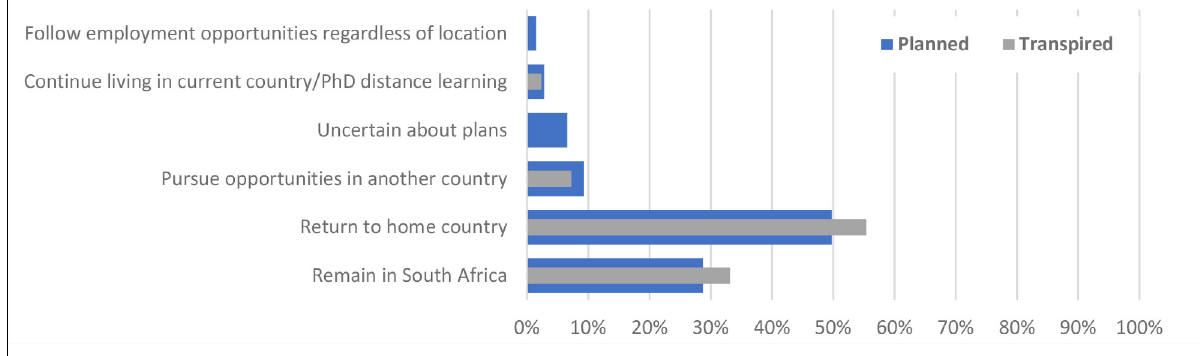
Figure 4: Mobility plans and outcomes of doctoral graduates from Africa.